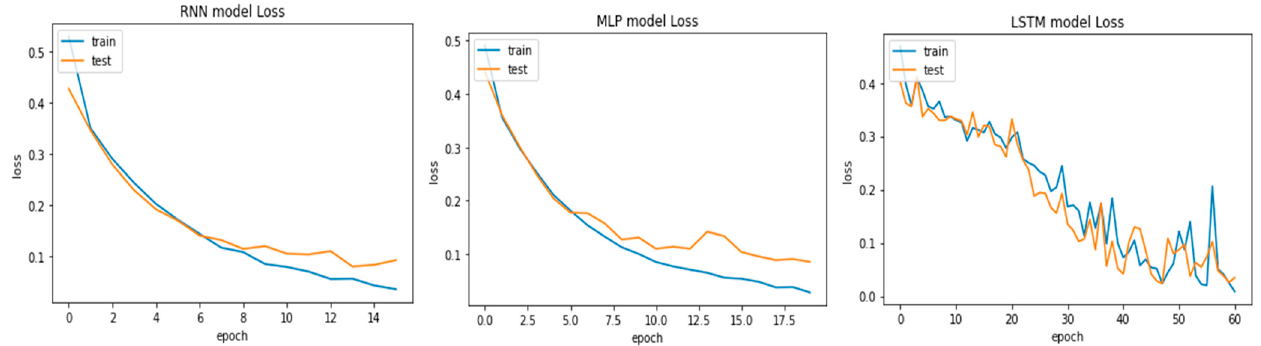
Figure 6. Testing and training accuracy of RNN (left), MLP (middle), and LSTM (right).